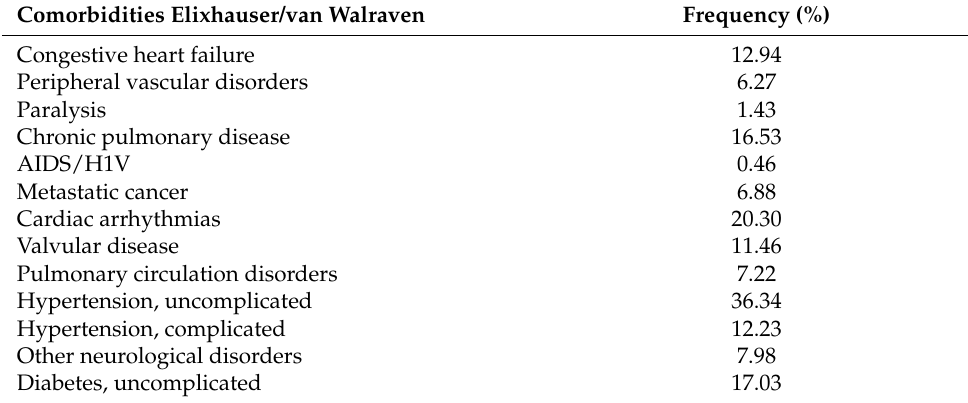
Table 2. Comorbidities of Elixhauser/van Walraven